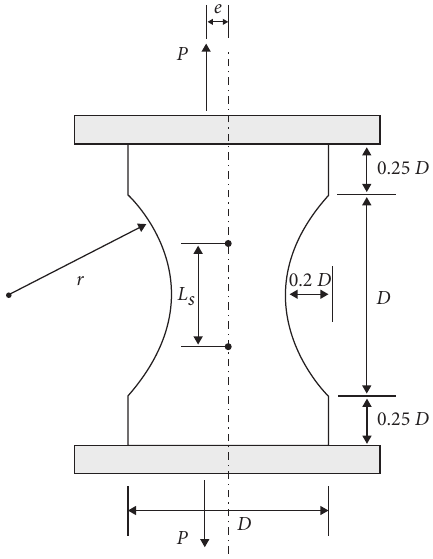
Figure 11: Plate subjected to an eccentric